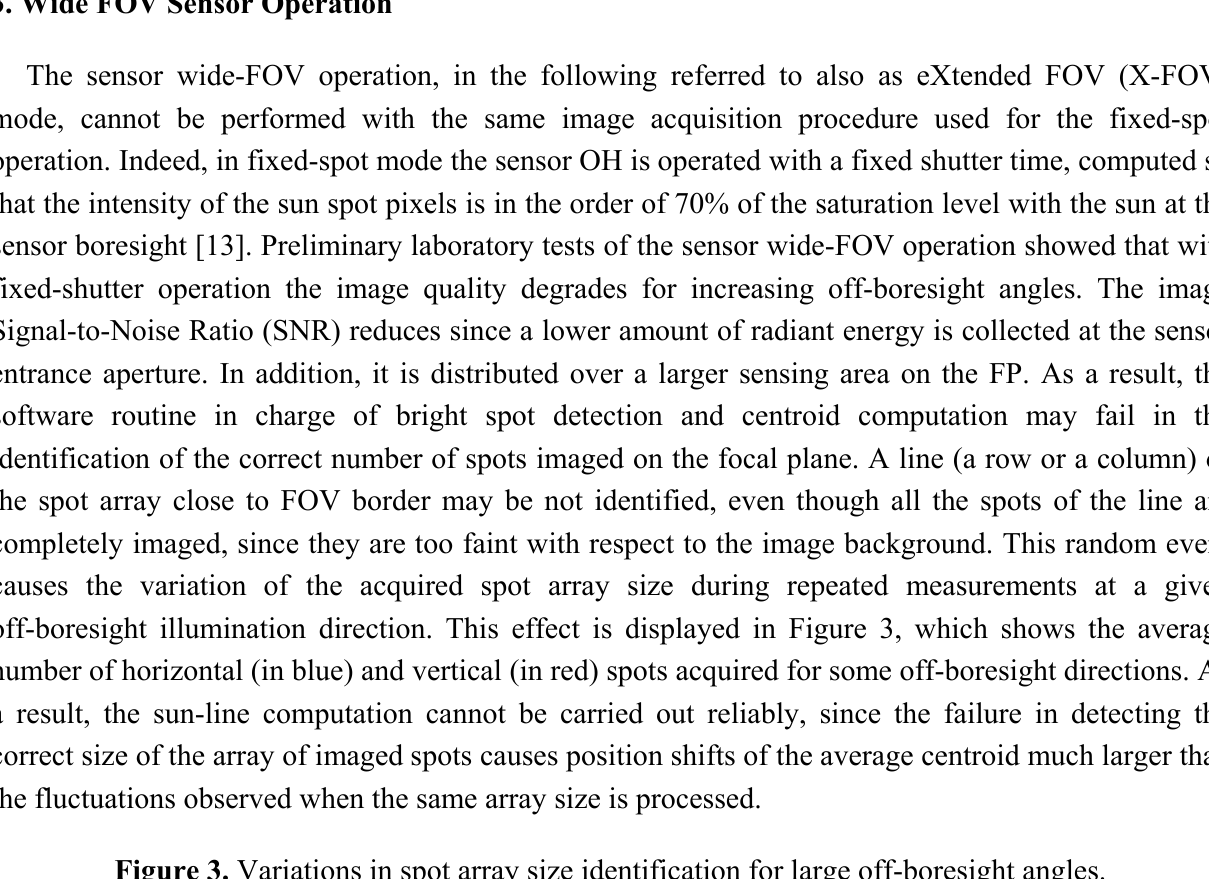
Figure 3. Variations in spot array size identification for large off-boresight